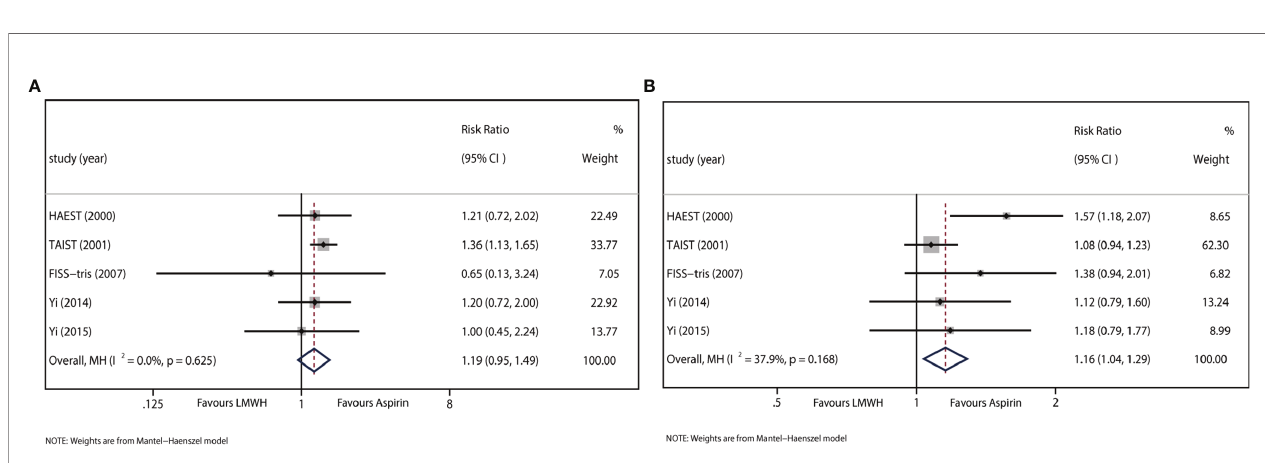
FIGURE 3 | (A) Forest plot of the effects of LMWH vs. aspirin on the outcome of sICH. (B) Forest plot of the effects of LMWH vs. aspirin on the outcome of extracranial